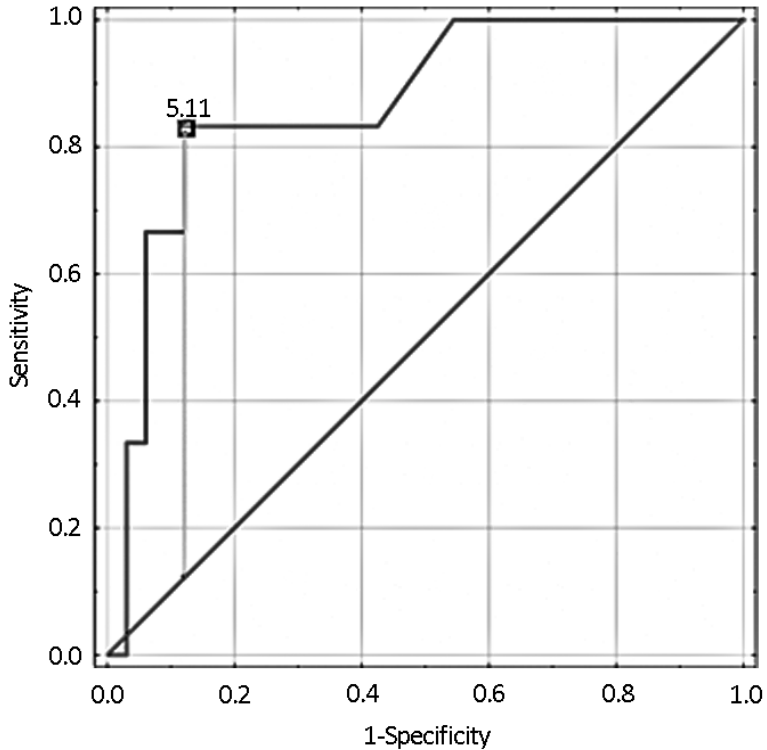
Figure 2. Receiver operating characteristic curve (ROC) representing efficacy of potassium concentration measured during resuscitation in prediction of survival until hospital discharge.